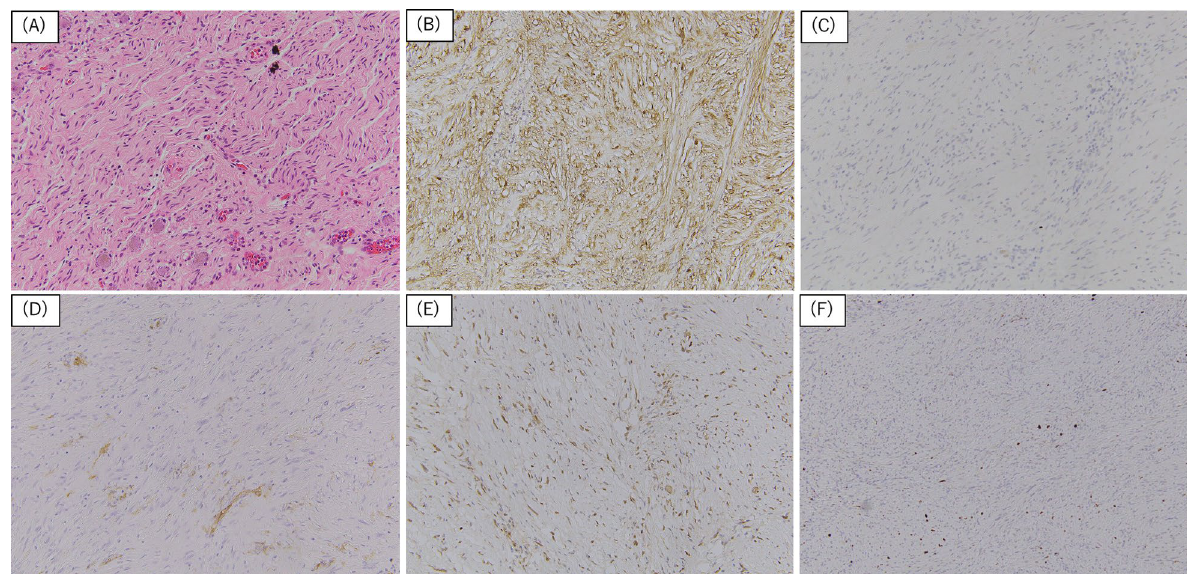
Fig. 5 Pathological findings. A Hematoxylin and eosin stain showed complicated spindle cells with polymorphic nuclei and eosinophilic cytoplasm ( 200). B Immunohistochemical stain for S100 was positive ( × (